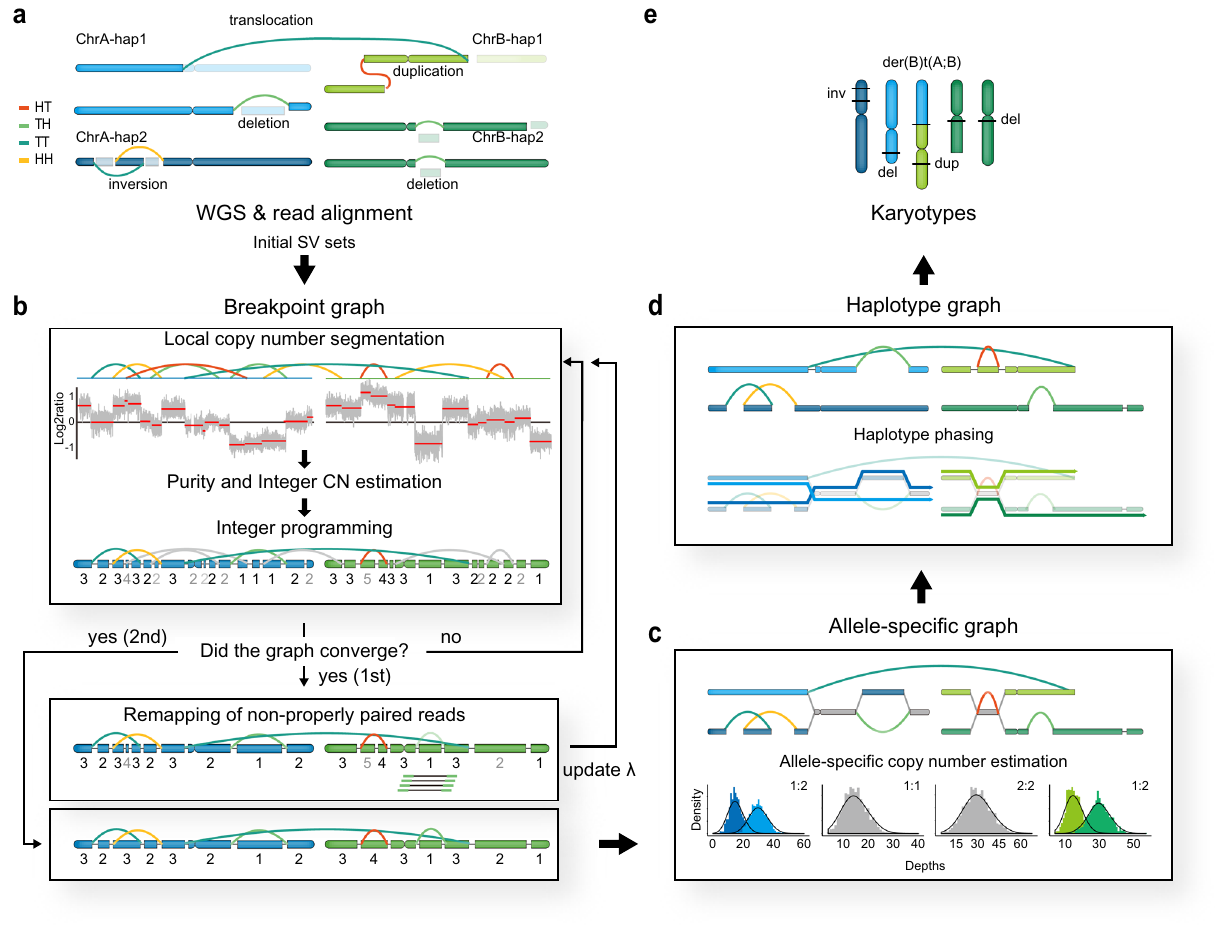
Fig. 1 Schematic diagram of InfoGenomeR steps. a Each of the two chromosomes (chrA and chrB) has two haplotypes (hap1 and hap2), with head-to-tail (HT), tail-to-head (TH), tail-to-tail (TT) and head-to-head (HH) SVs. b Breakpoint graph construction. After reads from whole-genome sequencing data (WGS) are aligned, a breakpoint graph that is composed of nodes and segment edges (blue and green boxes), reference edges (black lines) and SV edges (coloured lines) is constructed. An iteration consisting of three steps is shown in the fi rst box. The log 2 ratio represents a normalised copy number (CN), and numbers under the nodes are integer CNs (low-con fi dence CNs are shown in grey). Note that the false-positive edges change to grey edges after integer programming. Once the graph converges ( fi rst iterations), reads supporting a deletion (green) are remapped, and the segmentation parameter λ is updated before second iterations. c Allele-speci fi c graph construction. ASCNs are measured for each segment using a negative binomial model, and imbalanced segments are divided into allelic segments (light blue and blue for chrA, light green and green for chrB). Balanced segments (grey) remain in the same states in the breakpoint graph. d Haplotype graph construction. Allelic segments are phased into haplotypes using the HMM (blue and green arrows) to construct the haplotype graph. e The Eulerian path- fi nding problem in the haplotype graph fi nally reconstructs the cancer genome from the alignment data. Here, the example has unique